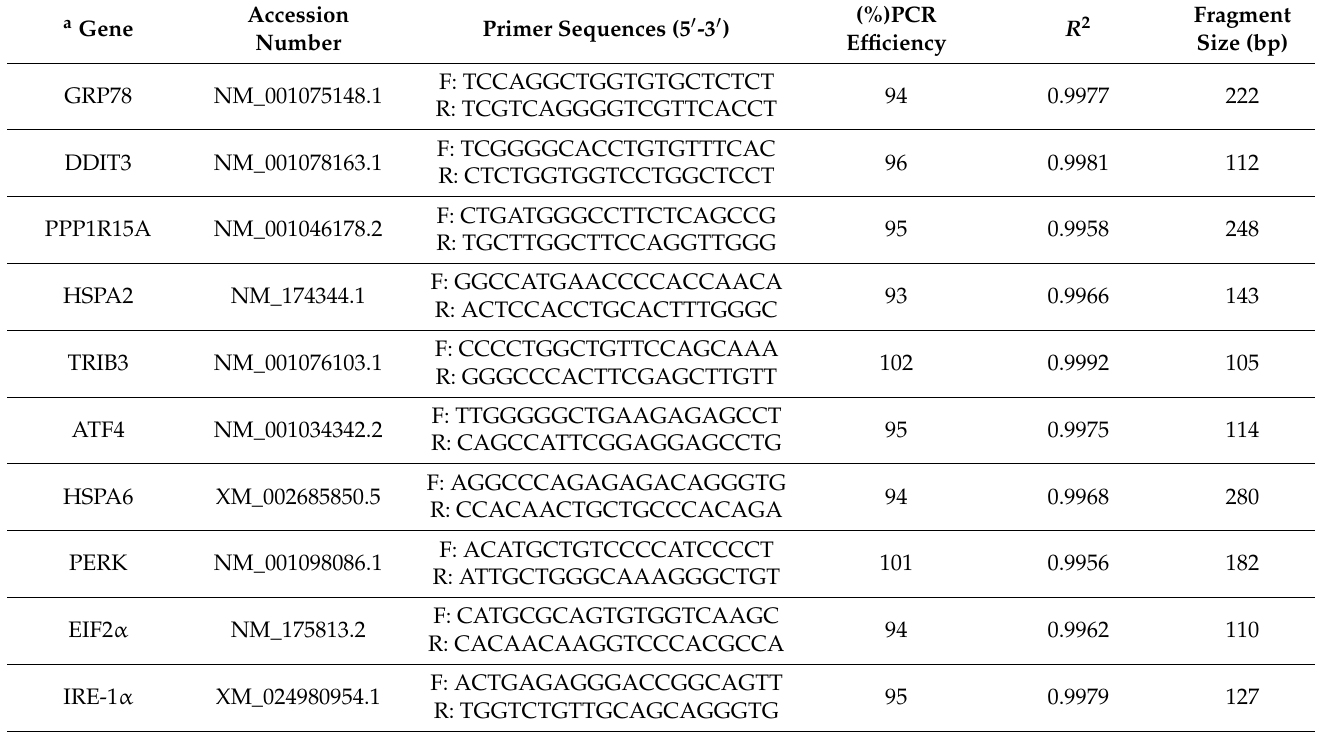
Table 1. Primers sequences for real-time quantitative PCR